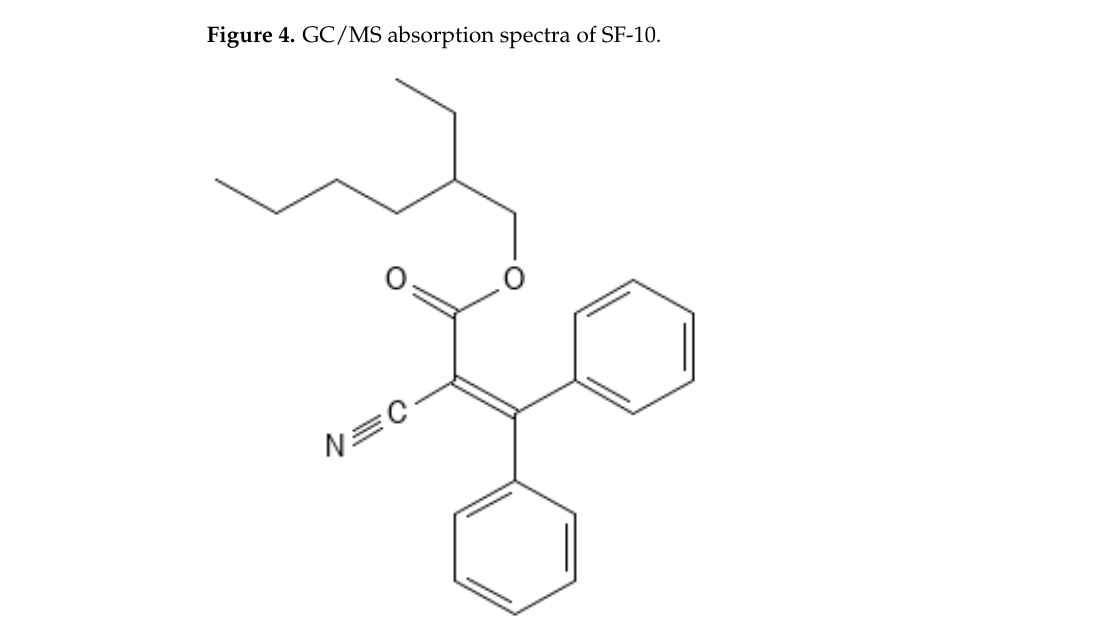
Figure 5. Identified compound and its structure. Table 4. Free radical scavenging activity of the identified compound.